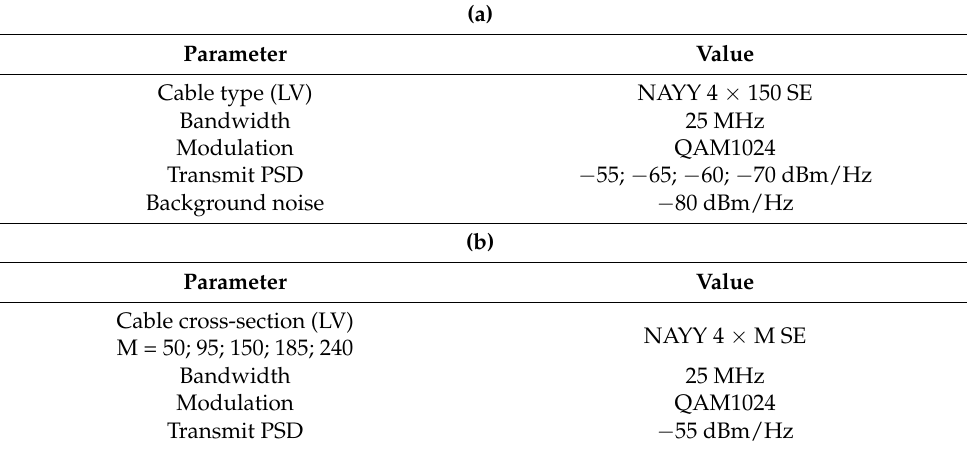
Table 9. Input channel parameters of ( a ) transmit PSD sweep; ( b ) cable cross-section